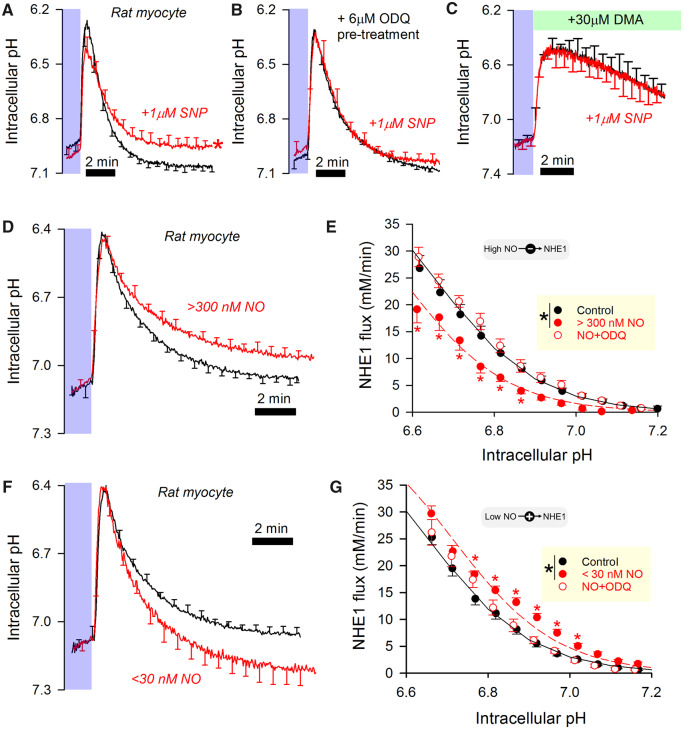
NO delivered from donors produces a concentration-dependent biphasic effect on NHE1 activity. (A) Wild-type rat myocytes. Hepes-buffered superfusates, 37°C. The short half-life NO donor, sodium nitroprusside (SNP), was added to solutions 4–6 min before activating NHE1. With 1 µM SNP, NO is expected to peak at 600 nM during pHi recovery (control: N = 35 cells from five animals; SNP: N = 31 cells from five animals). (B) Experiments repeated on myocytes that had been pre-treated with 6 µM ODQ (1H-[1,2,4]Oxadiazolo[4,3-a]quinoxalin-1-one), an inhibitor of guanylyl cyclase (GC; ODQ: N = 24 cells from four animals; ODQ+SNP: N = 26 cells from four animals). (C) CO2/HCO3−-buffered superfusates, 37°C; 30 µM dimethylamiloride (DMA) included to block NHE isoforms. pHi recovery mediated by HCO3− dependent transporters is unaffected by NO (control: N = 15 cells from three animals; SNP: N = 15 cells from three animals). (D) Wild-type rat myocytes. Hepes-buffered superfusates, 37°C. The long half-life NO donor NOC12 was added to solutions 10 min before activating NHE1. At a concentration of 5 µM, NOC12 is expected to maintain NO above 300 nM for the duration of pHi recovery. (E) NHE1 fluxes. Control (N = 21 from five animals), effect of NOC12 (N = 18 from five animals), and effect of NOC12 on ODQ-pretreated cells (N = 26 from five animals). Significant difference between control and NOC12 (P < 0.0001), but not between control and NOC12+ODQ (P = 0.06). (F) Lower concentrations of NO (<30 nM) were produced by mixing donor NOC12 (300 µM) with scavenger CPTIO (100 µM). (G) NHE1 fluxes. Control (N = 21 from five animals), effect of NOC12/CPTIO (N = 19 from five animals), and effect of NOC12/CPTIO on ODQ-pretreated cells (N = 10 from four animals). Significant difference between control and NOC12 (P < 0.0001), but not between control and NOC12/CPTIO+ODQ (P = 0.08).